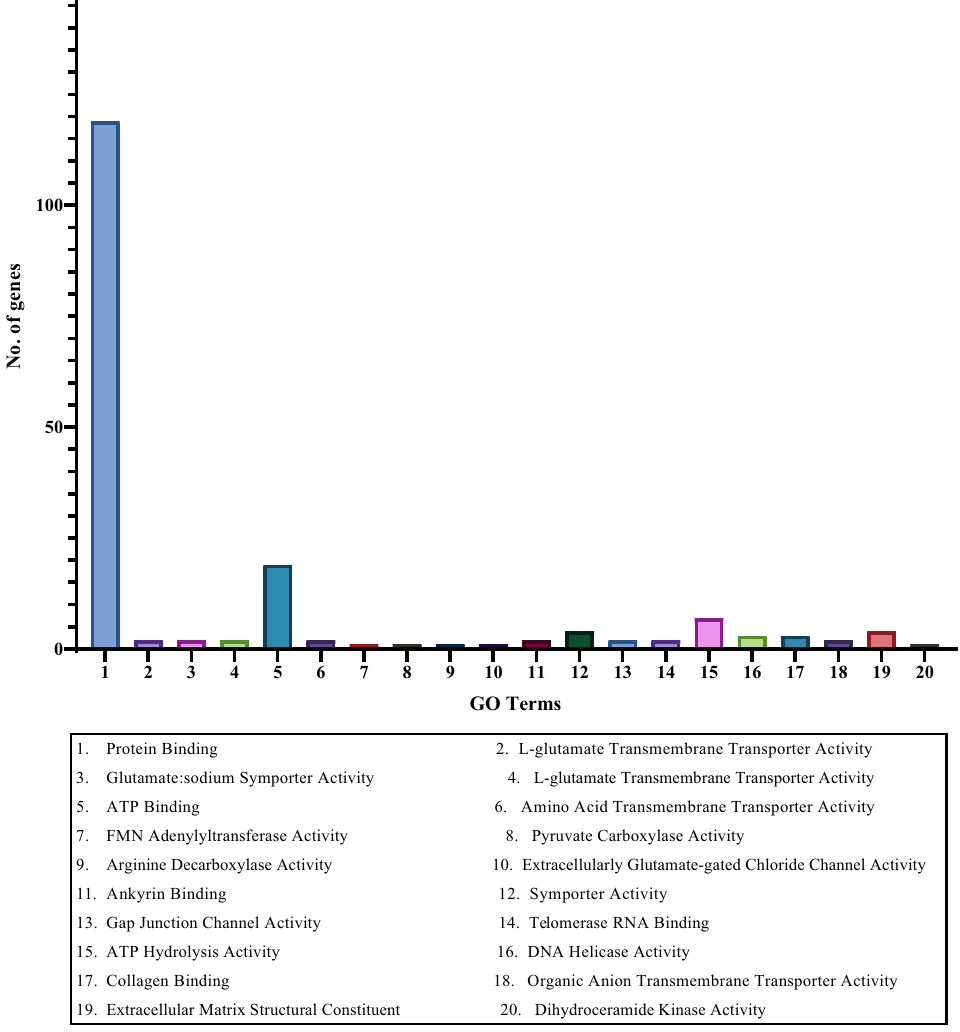
Fig. 9 Gene Ontology Study on Molecular Functions of Mural and Cumulus Granulosa Cells. The number of genes enriched in each molecular function is plotted along the vertical axis of the Molecular Functions bar